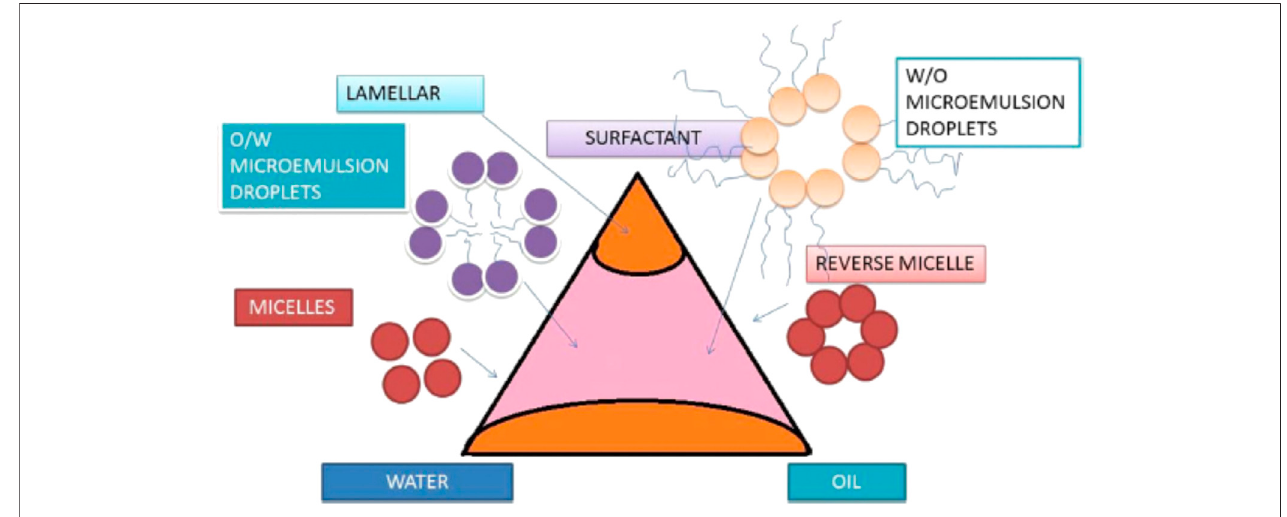
FIGURE 1 | Phase diagram of a microemulsion